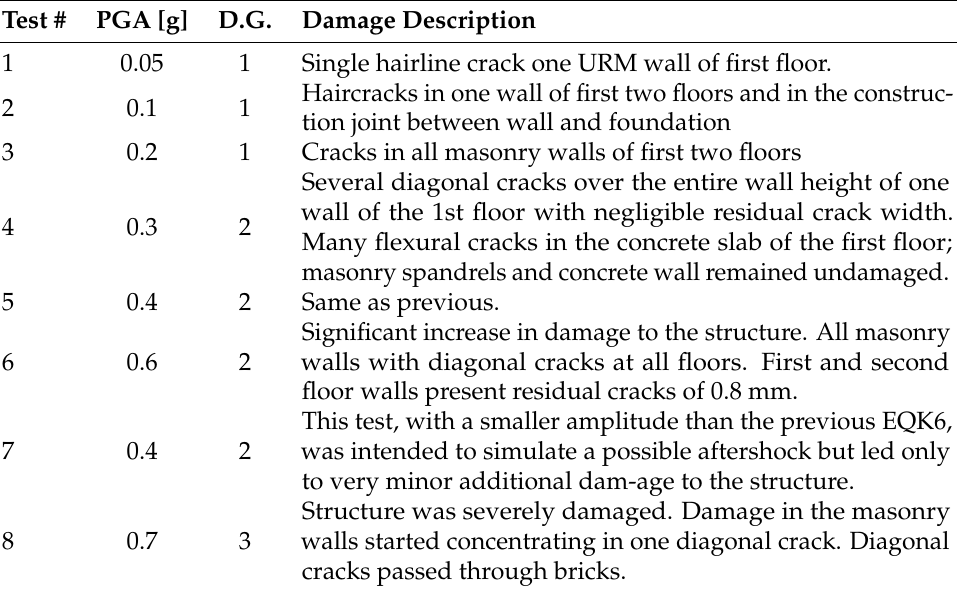
Table 3. Description of the eight earthquake sequences and the evolution of damage observed by Beyer et al.